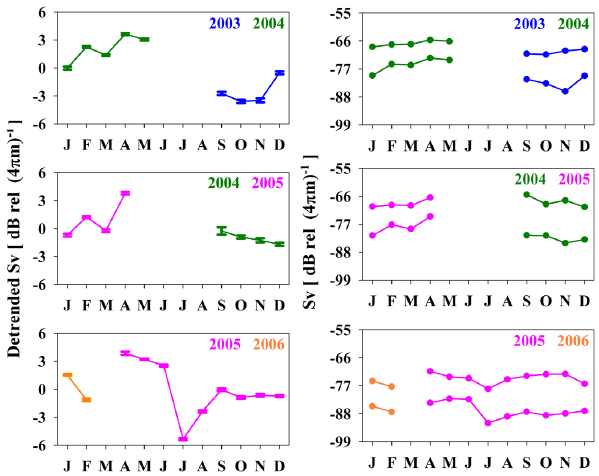
Fig. 4. Backscatter strength at 40m depth during the three deploy- ments: (left) detrended monthly averaged time series with error bars corresponding to uncertainties in the average estimation; (right) monthly maximum- and minimum values. Data from year 2003 in blue, 2004 in green, 2005 in pink, and 2006 in orange. Time axis aligned from January to December.